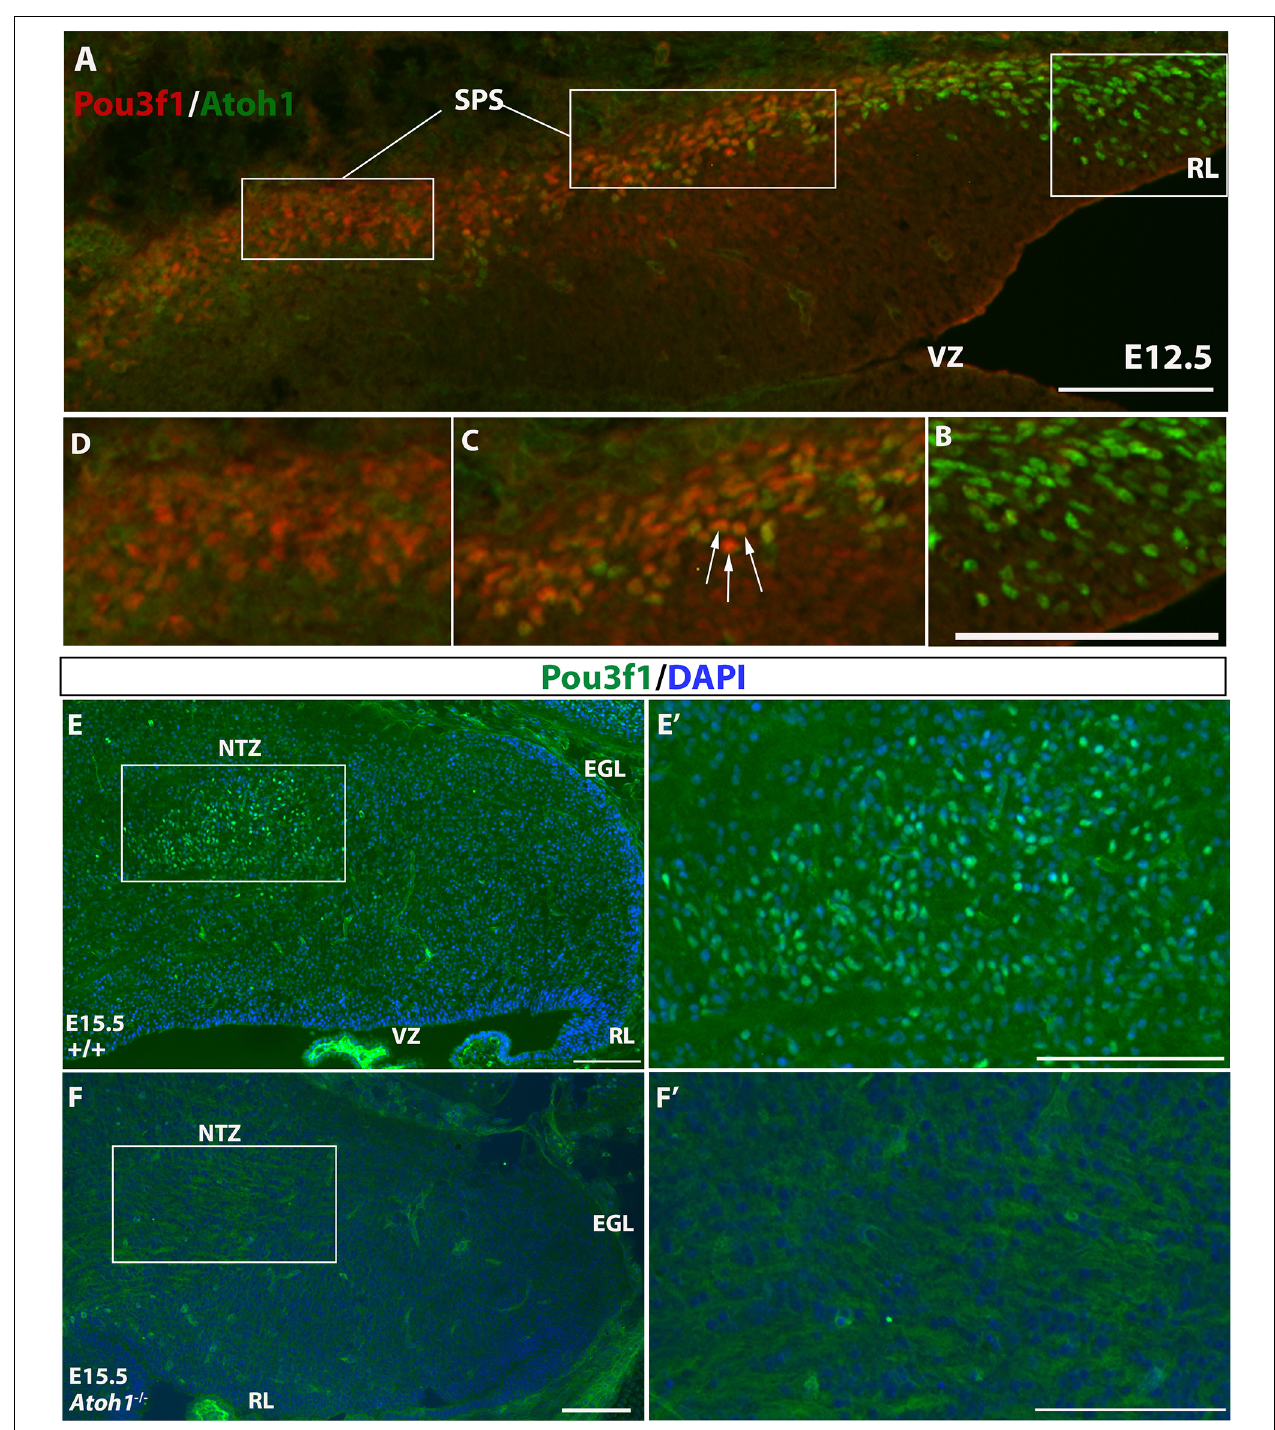
FIGURE 4 | The expression patterns of Atoh1 and Pou3f1 in the wild-type and Atoh1 -null cerebella. (A) Three molecular regions are demarcated by the expression of Atoh1 and Pou3f1 in the E12.5 cerebellar anlage (sagittal view): the rhombic lip (RL) is exclusively Atoh1 + ( B, right ), followed by the beginning portion of the subpial stream (SPS) characterized by co-localization of the two transcription factors ( C, middle , white arrows), and the rest of the SPS marked exclusively by Pou3f1 ( D, left ). (E,E’) In the E15.5 wild-type cerebellum (sagittal view), Pou3f1 expression is present in the nuclear transitory zone (NTZ). The boxed area in (E) is shown in (E’) in higher magnification. (F,F’) However, in the corresponding Atoh1 -null mutant cerebellum, Pou3f1 + cells are completely absent. The boxed area in (F) is shown in (F’) in higher magnification. EGL, external germinal layer; NTZ, nuclear transitory zone; RL, rhombic lip; SPS, subpial stream; VZ, ventricular zone. Scale bars, 100 µ